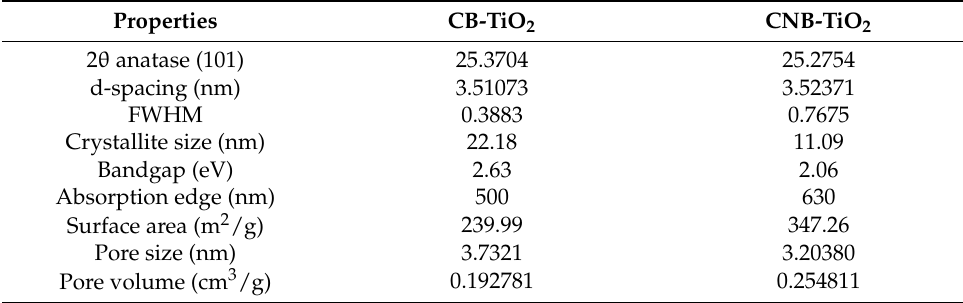
Table 1. Properties of the CB-TiO 2 and CNB-TiO 2